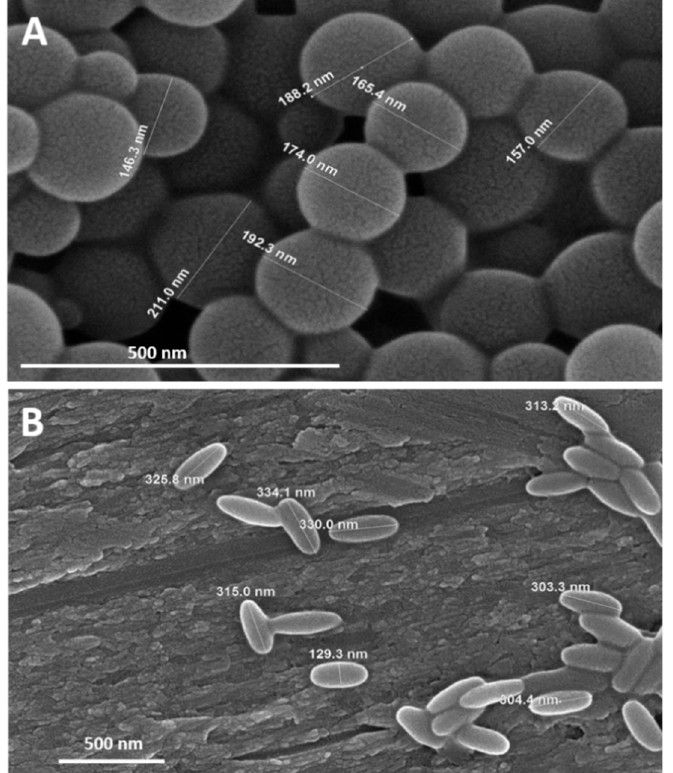
Figure 10. Scanning electron micrographs of spherical ( A ) and rod-shaped nanoparticles ( B ). Reproduced with permission from [81], Elsevier, 2019.